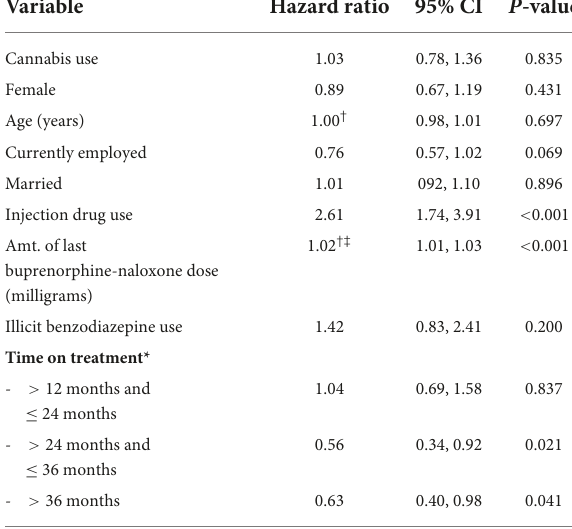
TABLE 2 Multivariable Cox regression analysis: Predictors of relapse amongst patients receiving buprenorphine-naloxone for OUD ( N =